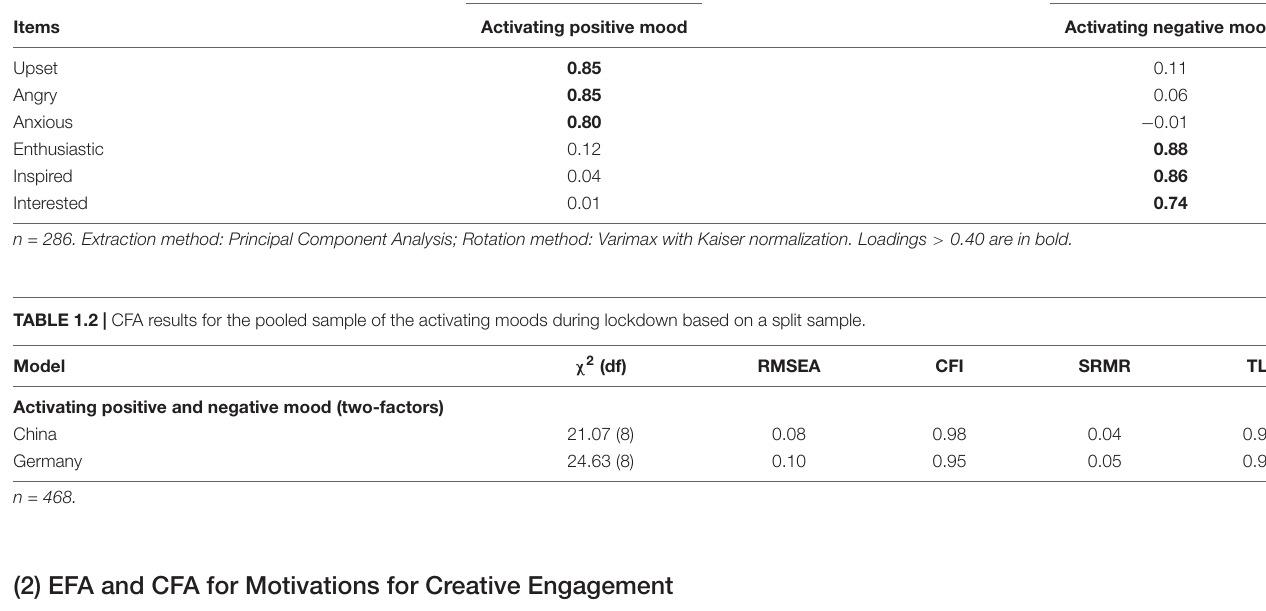
TABLE 1.1 | EFA results for the pooled sample of the activating moods during lockdown based on a split sample. Factor 1: Factor 2: